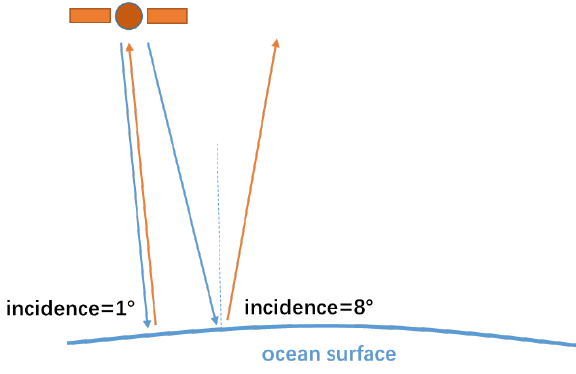
Figure 12. Schematic diagram of the intensity boundary phenomenon.